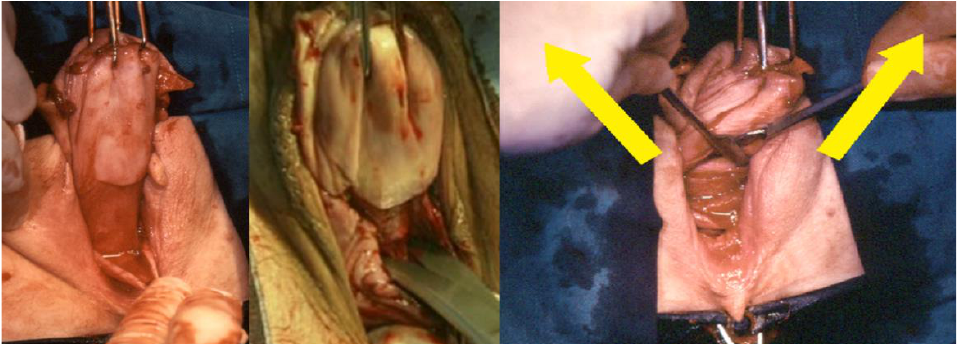
Figure 3. On the left, the exposure of the Douglas pouch peritoneum; in the center, the incision of the peritoneum with scissors; on the right, the scissors are pulled out while opened to expose the Sacro-Uterine ligaments.